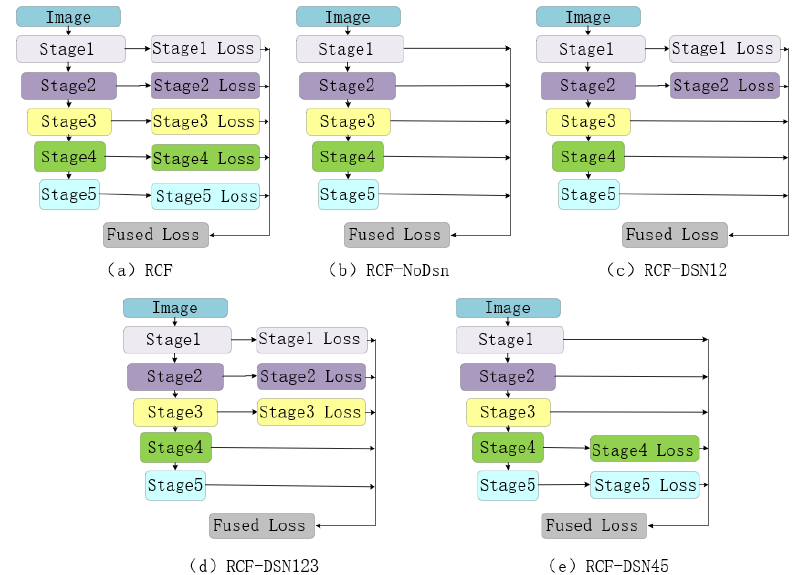
Figure 8. RCF networks with different Deeply-Supervised